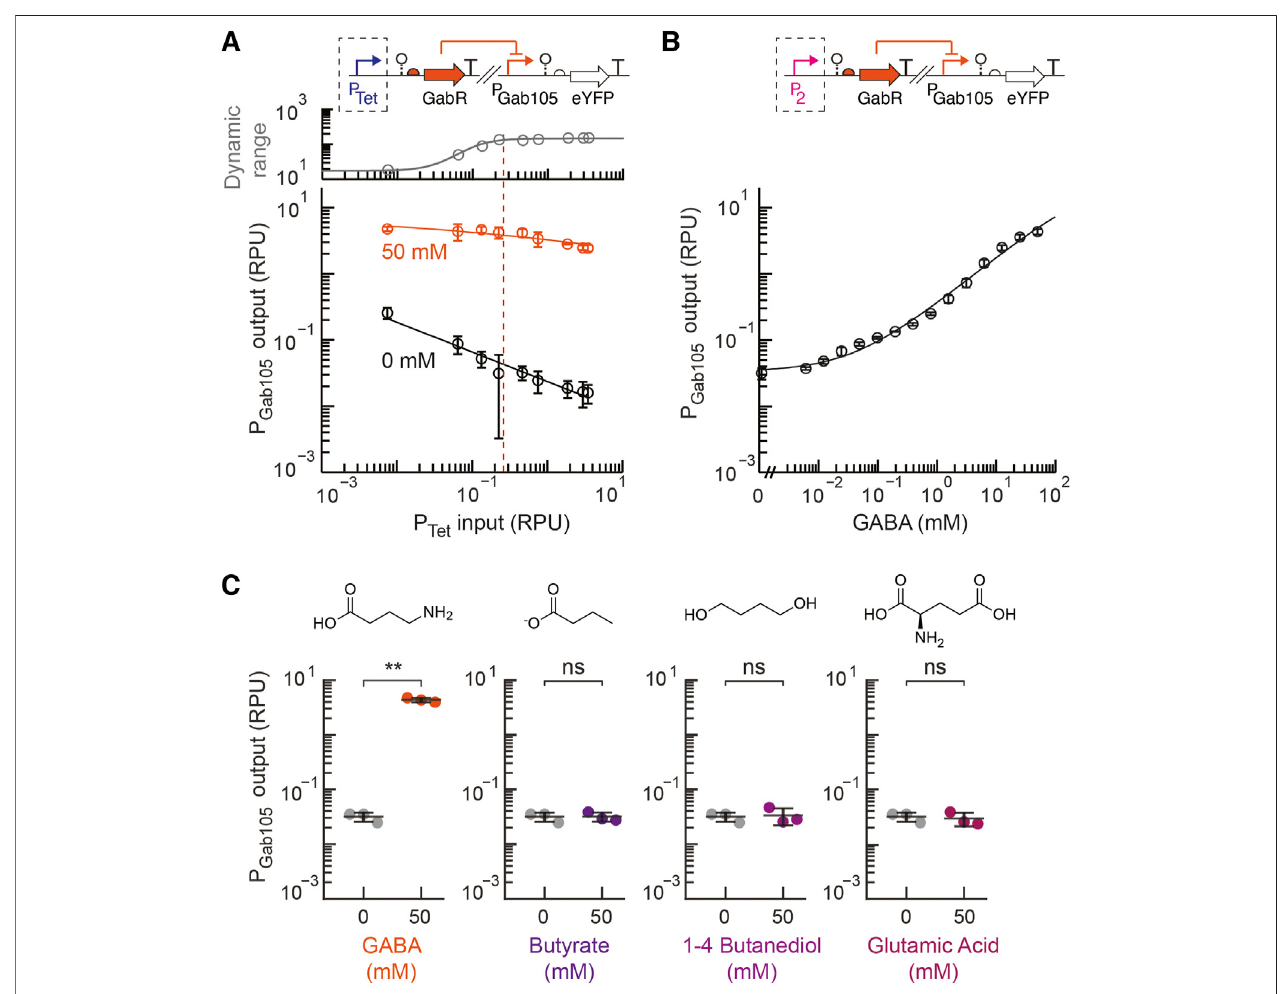
FIGURE 3 | Engineering a GABA sensor for EcN. (A) The prototyping design for the GABA sensor (pML3002), which contains the synthetic GabR-regulated P Gab105 promoter and inducible GabR by P Tet , was assayed for a range of inducer concentrations (aTc) with 50 mM GABA exogenously added (blue) to the medium or without GABA addition (black). The plotted dynamicrange was calculated as the ratio of the average promoter output with GABA addition to without GABA. The dotted line shows the selected optimal promoter input for the selection of the constitutive P 2 promoter. (B) The response of the fi nal GABA sensor design (pML3009) to GABA was assayed and fi t to the Hill equation. (C) The selectivity of the fi nal GABA sensor design (pML3009) was assayed with exogenous addition of 50 mM of either GABA, butyrate, 1 – 4 butanediol, or glutamic acid and compared to the medium without metabolite addition. For all panels, the cell fl uorescence was measured via fl ow cytometry,andarbitrary fl uorescenceunitswereconvertedtostandardRPU(Methods).Thebarsandmarkersrepresenttheaverageofthemeasuredgeometricmedian of a population of at least 5,000 cells assayed in three identical experiments performed on three different days. All error bars represent the standard deviation. Student ’ s t -tests (paired, two-tailed) were performed, and p -values ≤ 0.01 (**) and ≤ 0.05 (*) are indicated.